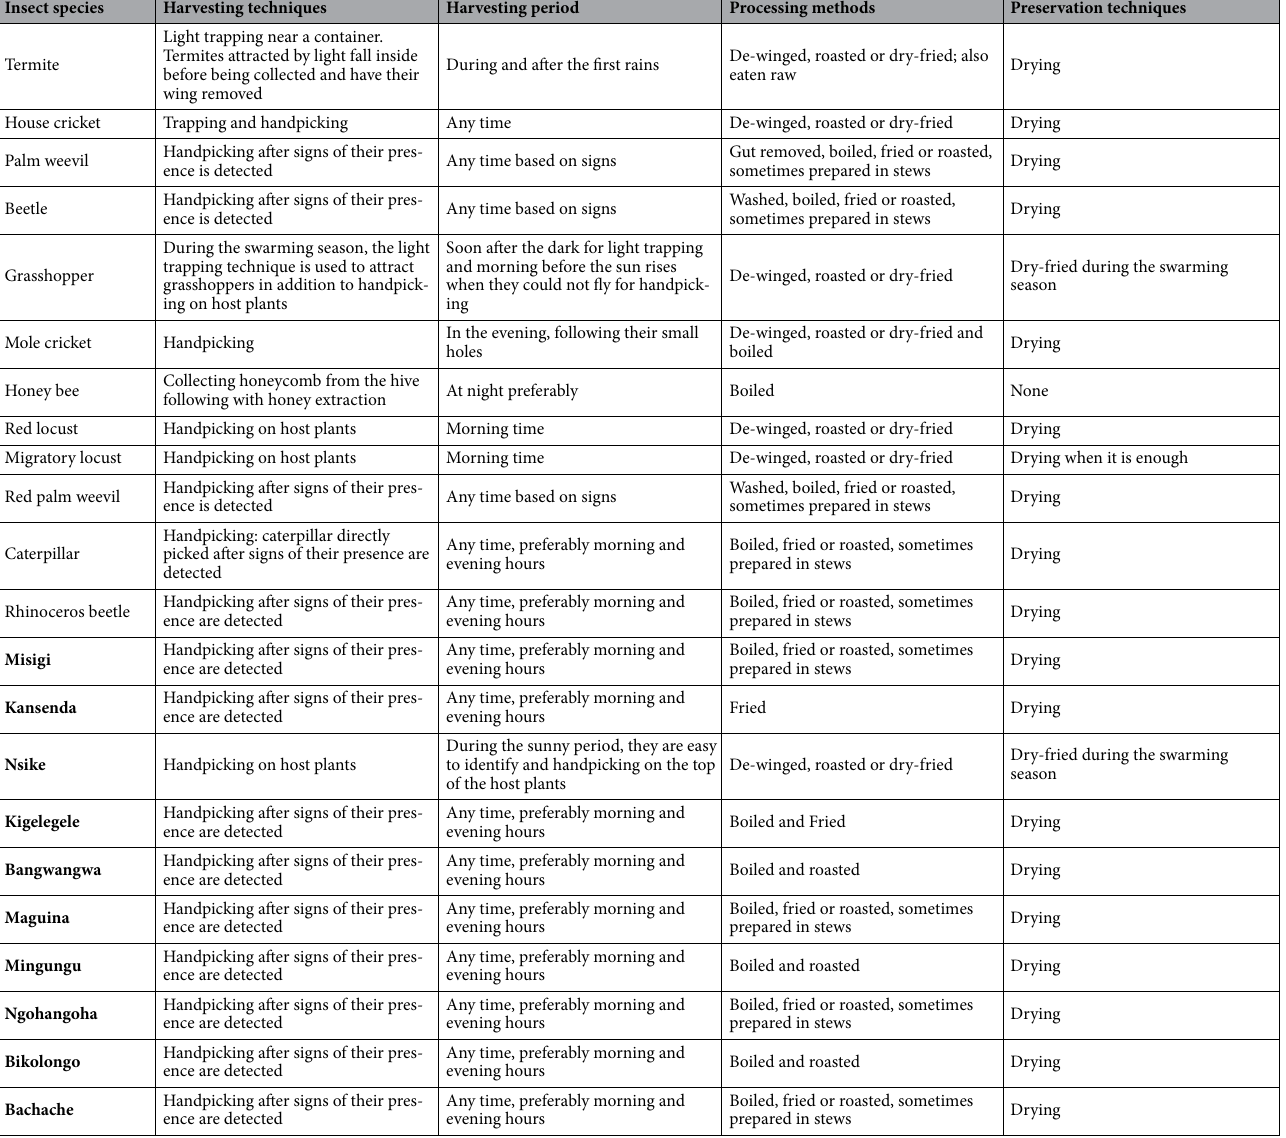
Table 5. Harvesting and processing techniques for various consumed edible insects in selected